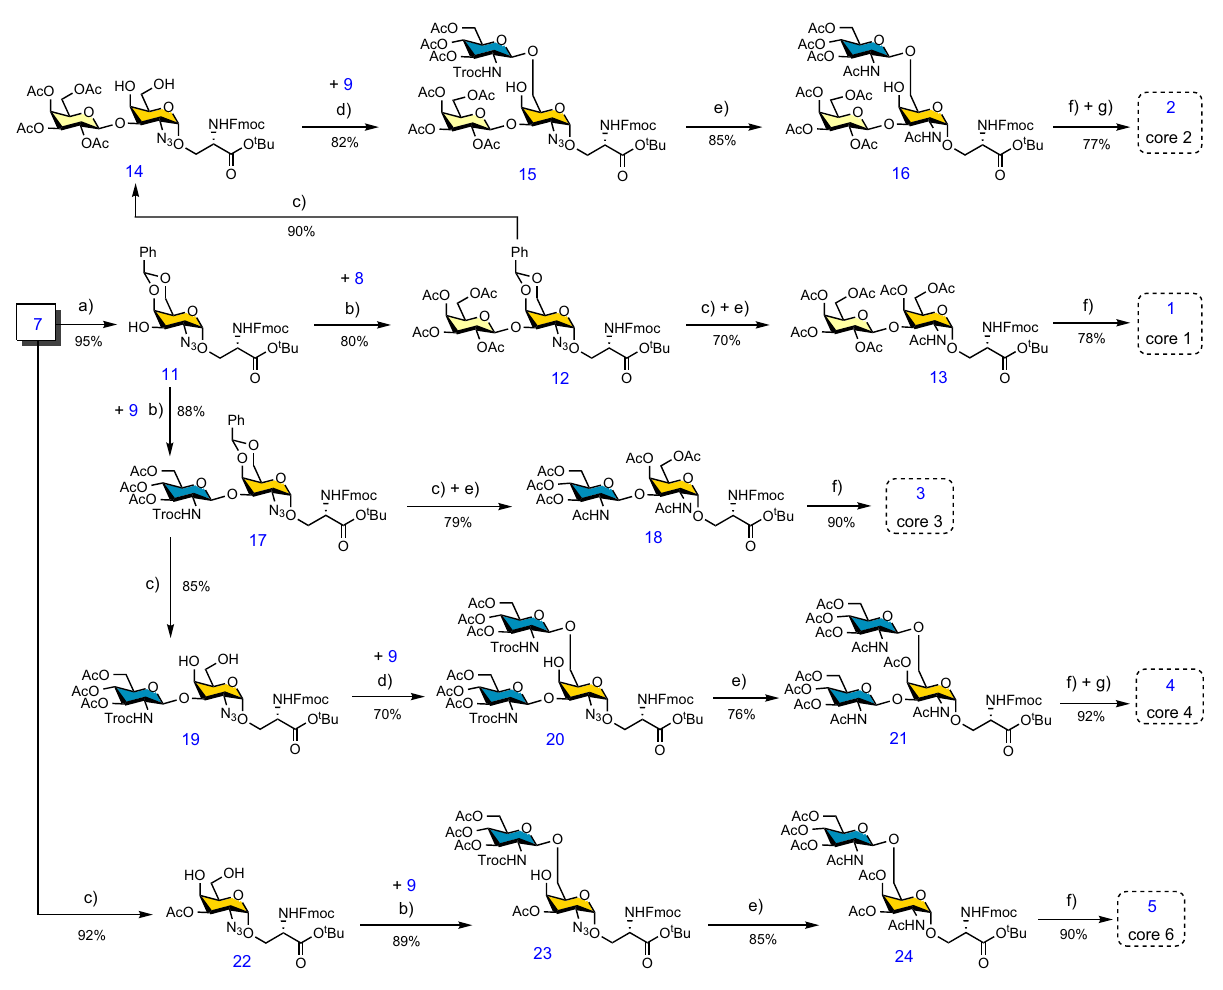
Fig. 3 Chemical modular assembly of O-GalNAc cores 1 – 4 and 6 structures. Reagents and conditions: a NaOMe, MeOH. b TMSOTf, CH 2 Cl 2 , −